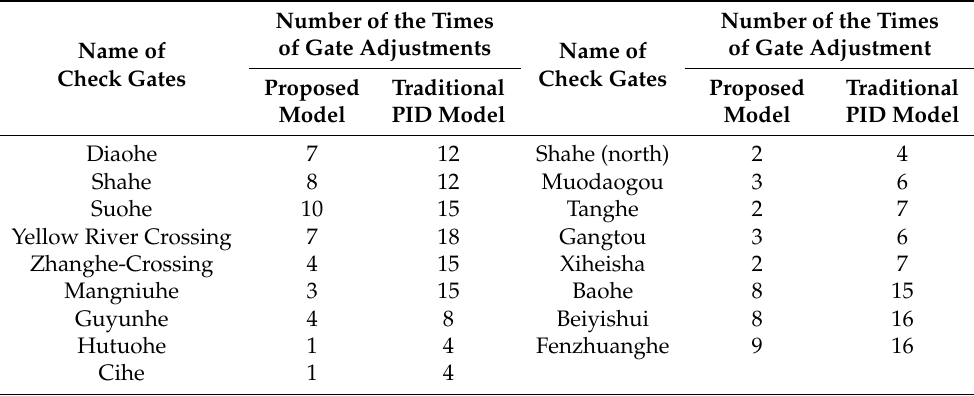
Table 3. Comparison of the total times of gate